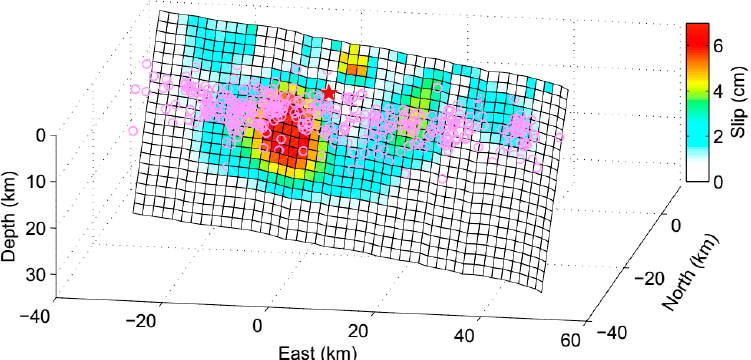
Figure 7. Slip uncertainties estimated from the 100 perturbed datasets generated using the Monte Carlo method. The epicenter is marked by a red star for clarity. The pink circles are the relocated aftershocks [1]. For clarity, a color palette different from Figure 6 is used.